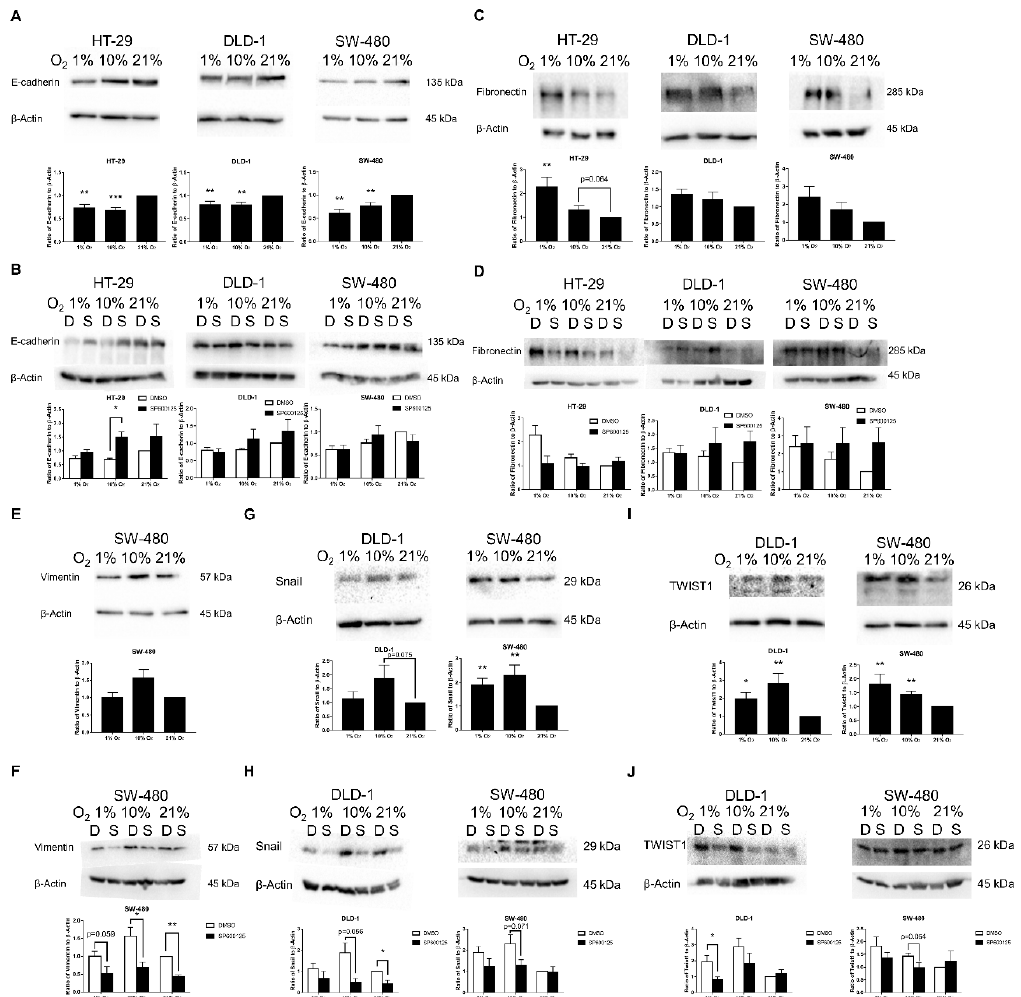
Figure 4. Epithelial–mesenchymal transition (EMT) marker and transcription factor expressions under different oxygen levels. EMT markers and transcription factors were evaluated by Western blotting in different oxygen levels on HT-29, DLD-1, and SW-480 cell lines. The key epithelial EMT marker E-cadherin was significantly down-regulated in all three studied cell lines in 1% and 10% O 2 ( A ) JNK inhibitor SP600125 (10 µM) could generally up-regulate E-cadherin in different oxygen levels, especially for 10% O 2 in HT-29 ( p < 0.05) ( B ) The mesenchymal EMT marker fibronectin was generally up-regulated in lower oxygen levels with 1% O 2 in HT-29 having significant up-regulation ( C ) HT-29 experienced down-regulation of fibronectin in the presence of SP600125, while DLD-1 and SW-480 had up-regulation of fibronectin in 10% and 21% O 2 by SP600125 ( D ) Another mesenchymal EMT marker, vimentin, was only detectable in SW-480; it was mildly promoted in 10% O 2 but not in 1% O 2 ( E ) SP600125 could substantially reduce vimentin expression under different oxygen levels, especially for 10% and 21% O 2 ( F ) EMT transcription factors Snail and TWIST1 expression levels in different oxygen levels were evaluated in DLD-1 and SW-480 ( G – J ) Substantial promotions of Snail in lower oxygen levels were found with SW-480 having significant increase in 1% and 10% O 2 ( G ) Snail was generally suppressed by SP600125 with more prominent effects in DLD-1 ( H ) TWIST1 also had significant promotion in lower oxygen levels among SW-480 and DLD-1 ( I ) and it experienced a suppression effect by SP600125 in both 1% and 10% O 2 ( J ) The data (means ± SEM) were expressed as the relative expression compared with 21% O 2 group, N = 9 (HT-29 and DLD-1) or 10 (SW-480) ( A , C , E , G , I ) The data (means ± SEM) were expressed as the relative expression compared with 21% O 2 + DMSO group. N = 9 (HT-29 and DLD-1) or 10 (SW-480) for DMSO group, N = 4 (HT-29) or 5 (DLD-1 and SW-480) for SP600125 group ( B , D , F , H , J ). * p < 0.05, ** p < 0.01, *** p < 0.001. D: DMSO (0.1%), S: SP600125 (10 µM).